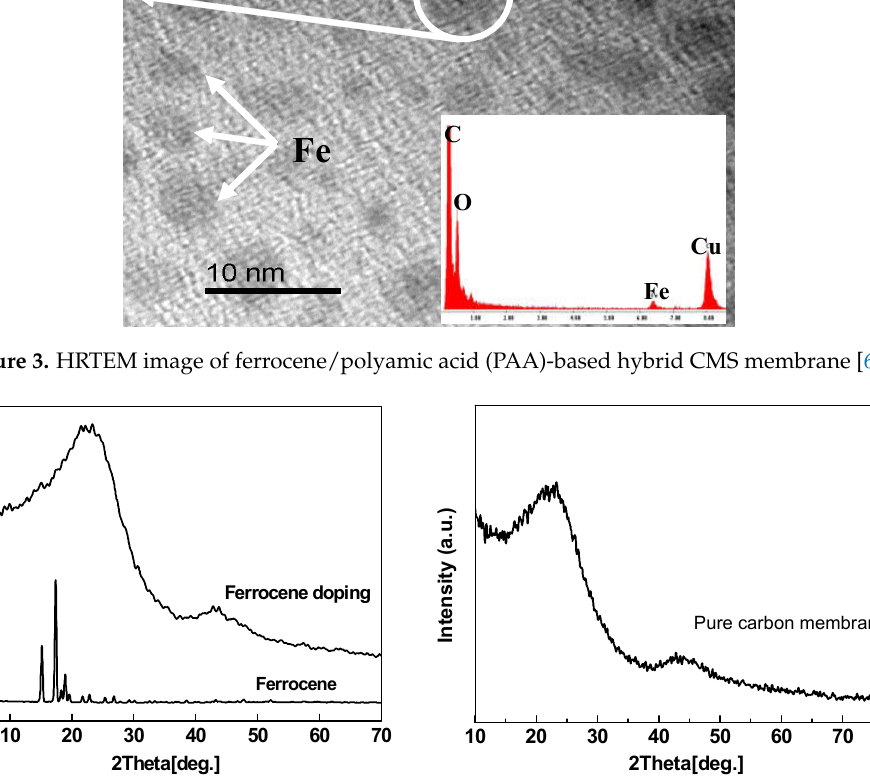
Figure 3. HRTEM image of ferrocene/ polyamic acid (PAA)-based hybrid CMS membrane [63]. Table 2. Gas permeability and selectivity for ferrocene/PAA-based Fe/C hybrid membranes [63] (Testing condition: 0.05 MPa, 25 °C, the same below).